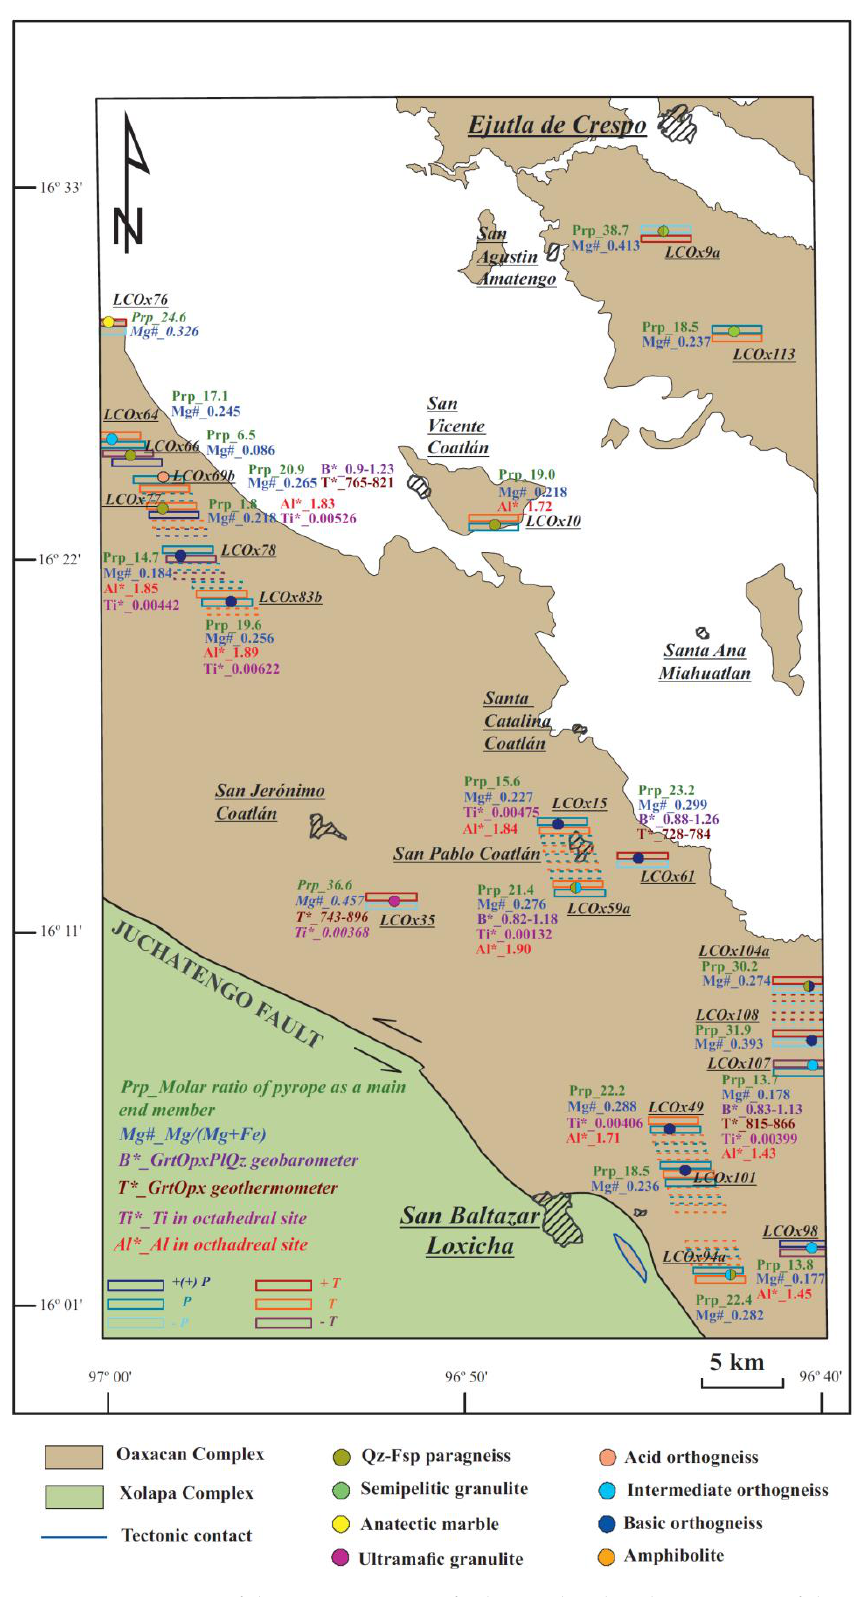
Figure 9. A summary of the most important findings related to the geometry of the orogen in the study site. In this figure, the molar ratio of Prp as the main end member, Mg/Mg + Fe, Ti, and Al in octahedral site data together with the Grt-Opx-Pl-Qz geobarometer and Grt-Opx geothermometer results obtained are represented.